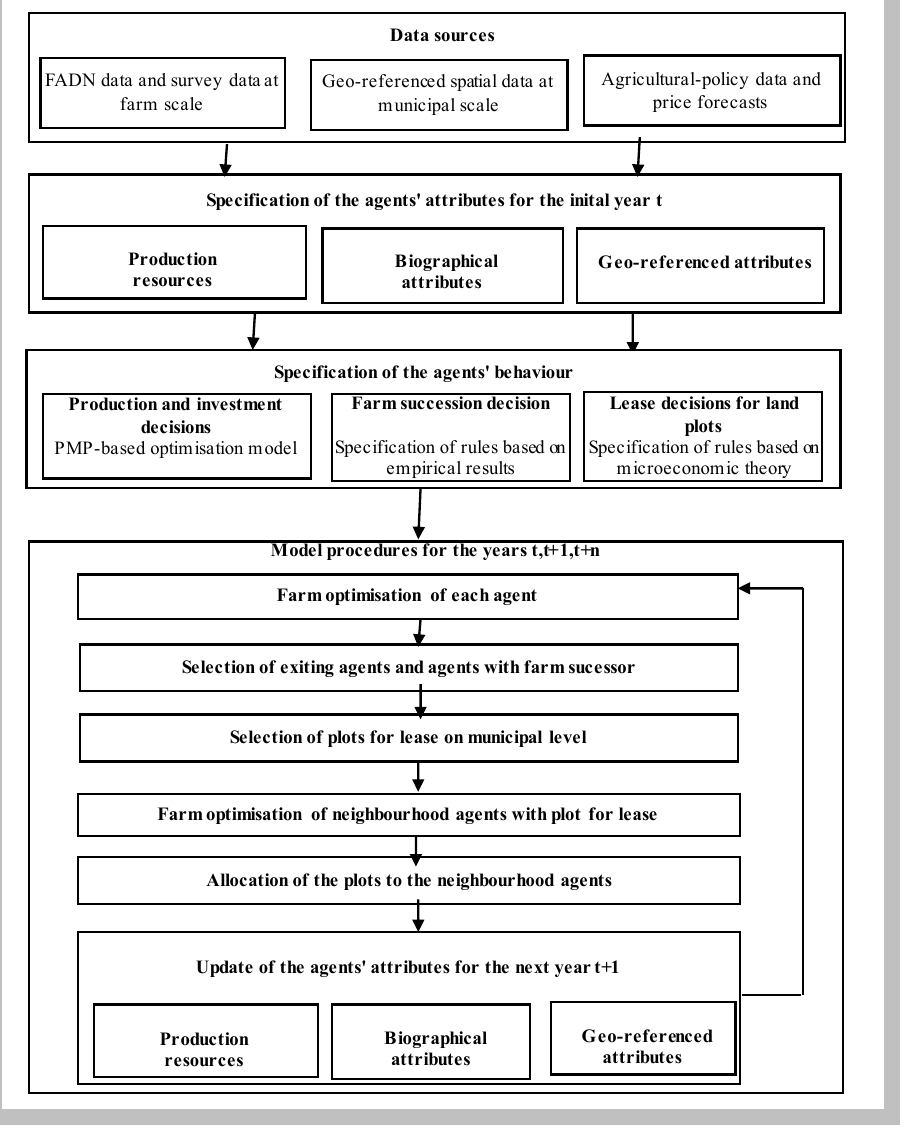
FADN data and survey data at farm